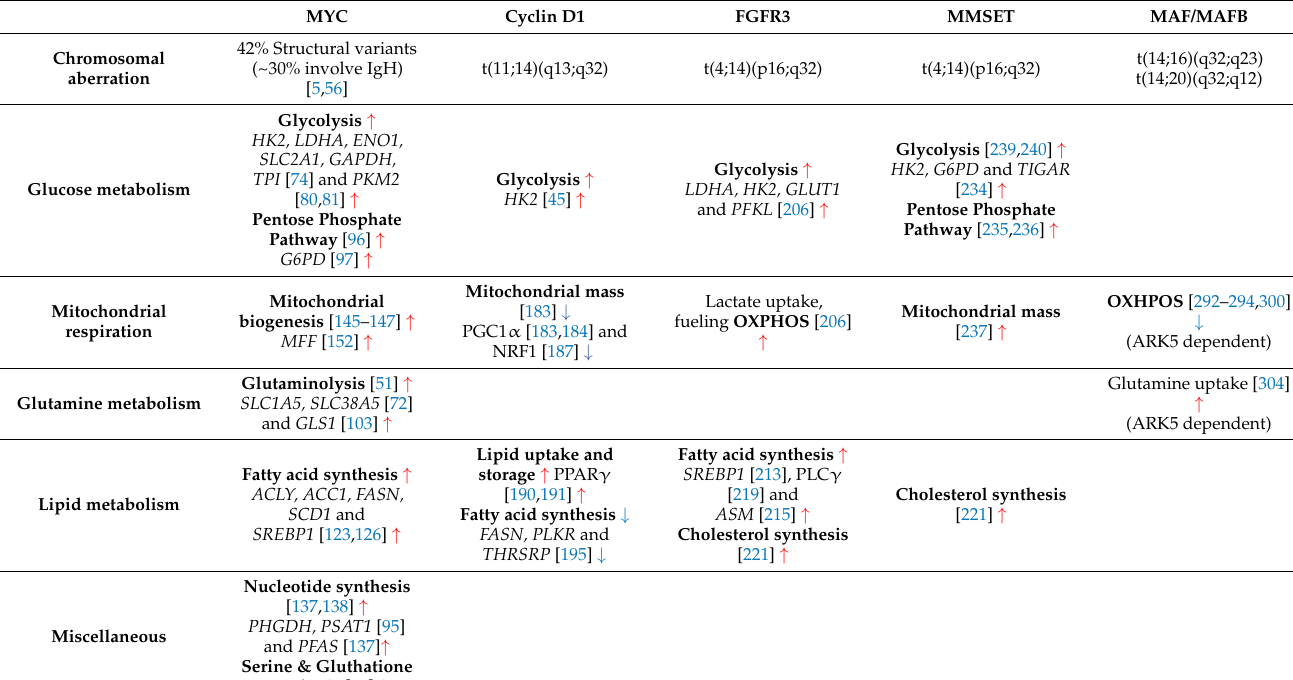
Table A1. General metabolic consequences of recurrent chromosomal aberrations in multiple myeloma. MYC Cyclin D1 FGFR3